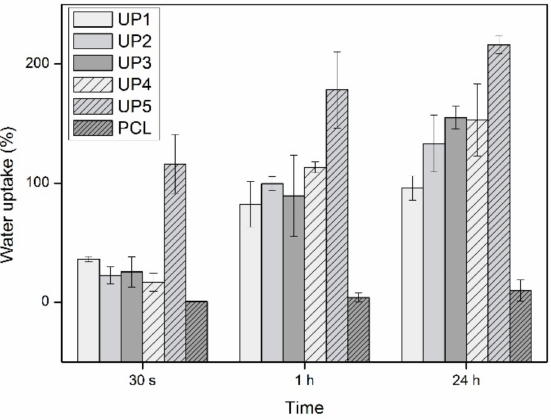
Figure 5. Water uptake ability (%) of PCL and UP scaffolds as a function of time ( n = 3).